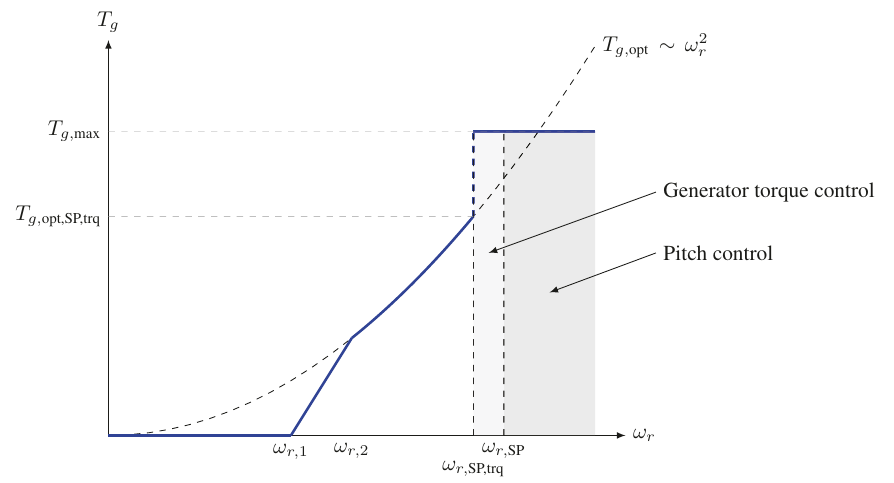
Figure 6. Regions of wind turbine control; Total Generator torque for the fault-free case dependent upon the rotor angular speed.